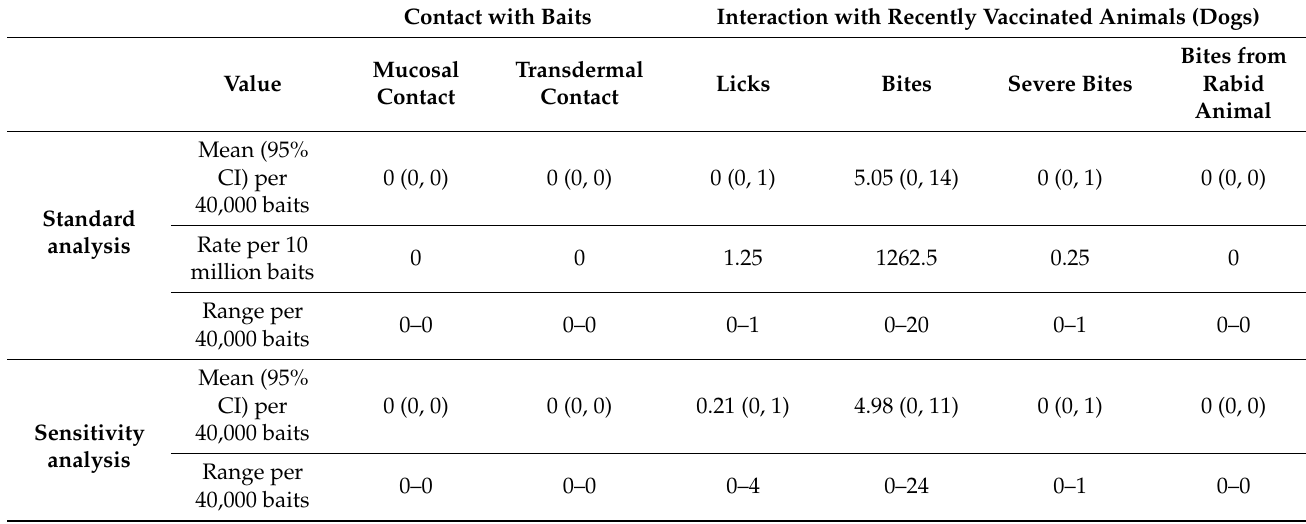
Table 4. Types of exposures estimated from a 40,000 bait ORV campaign using estimated parameters for Goa,